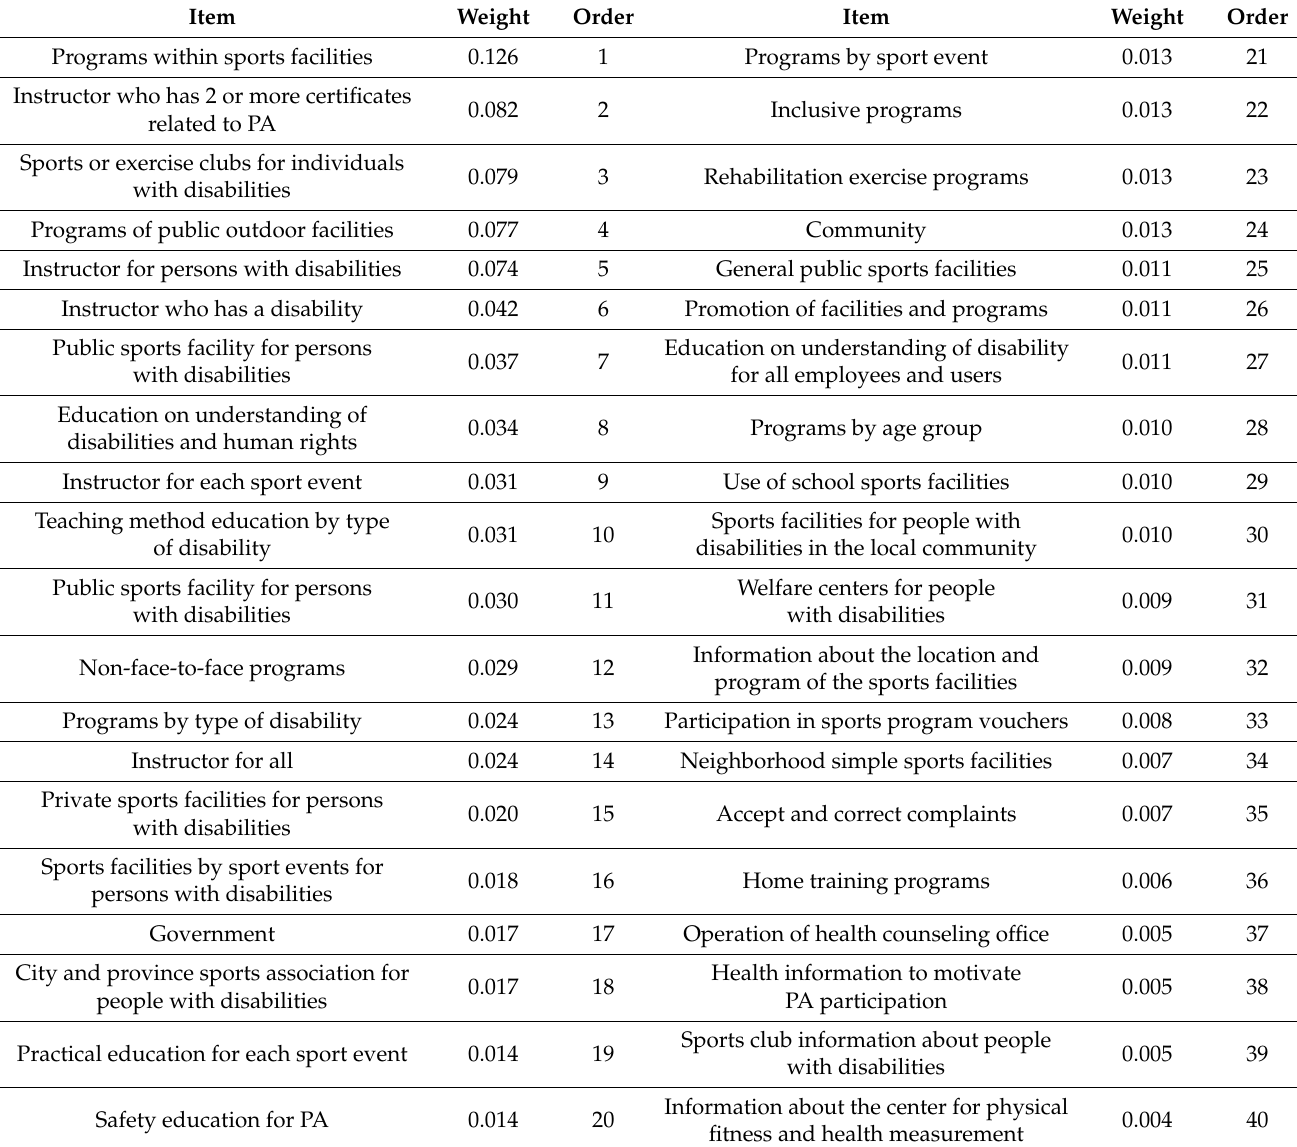
Table 15. Results of the priority of